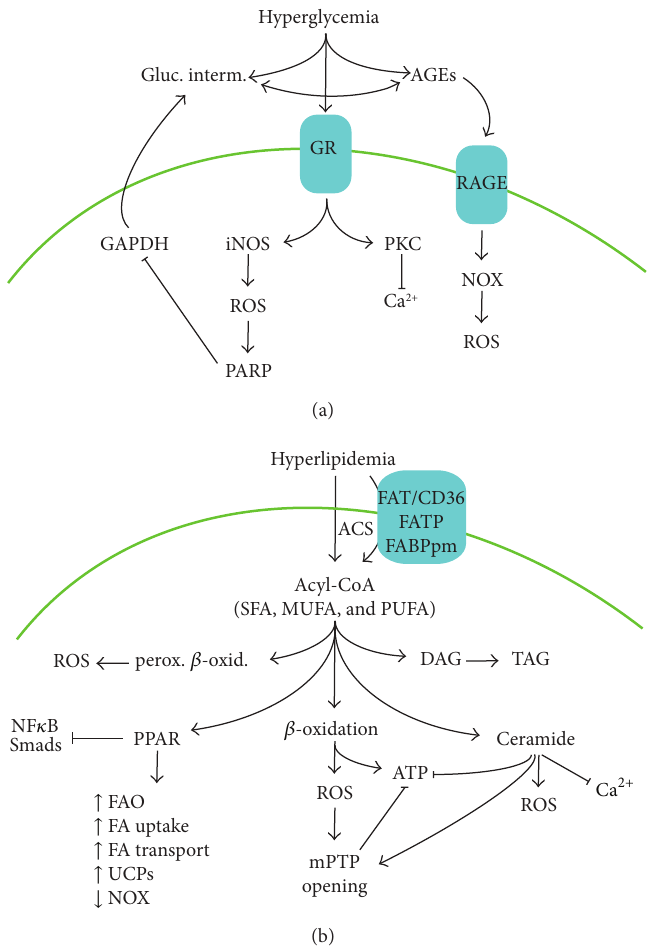
Figure 2: Hyperglycemia, hyperlipidemia, and myocardial ROS production. In diabetes, both the excess of plasma glucose (a) that cannot be properly assimilated by the tissues and the abundance of plasma lipids (b) may induce oxidative stress in the heart by different mediators. UCPs, uncoupling